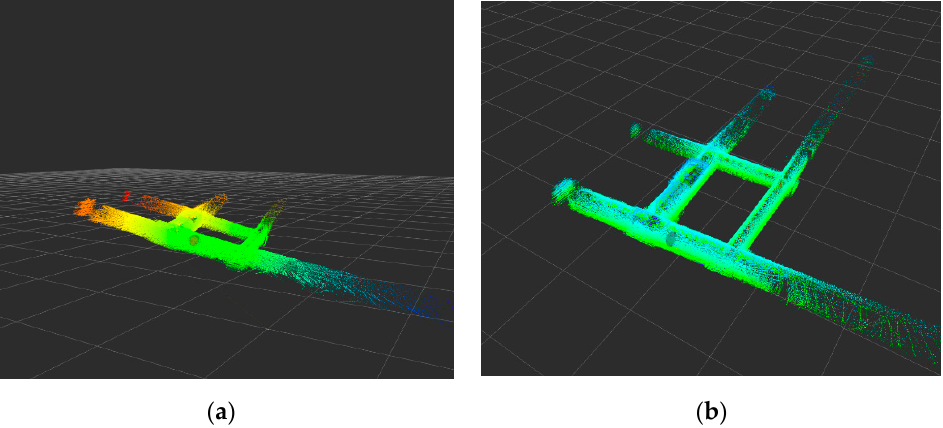
Figure 15. Effect of plane detection constraints on localization and mapping in pose graph. ( a ) Without loop detection, ( b ) with loop detection.